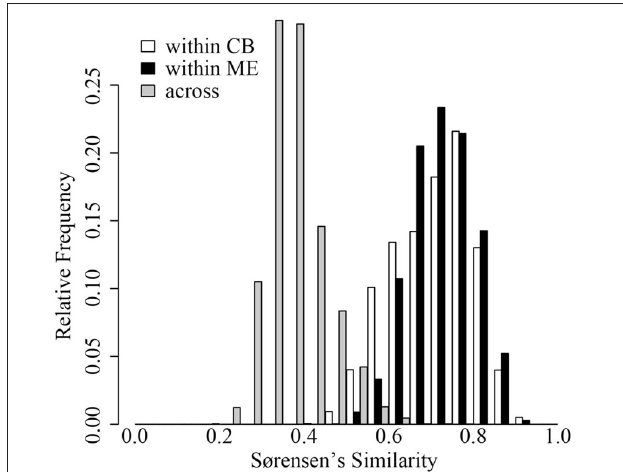
FIGURE 2 | Distribution of Sørensen’s similarity indices within 32 sites in Crystal Bog (within CB; open bars), within 32 sites in Lake Mendota (within ME; black bars), and between sites in Crystal Bog and Lake Mendota (across lakes; gray bars). Similarities were calculated as pair-wise comparisons of all samples within a set (e.g., 512 pairwise combinations for the 32 sites in CB).